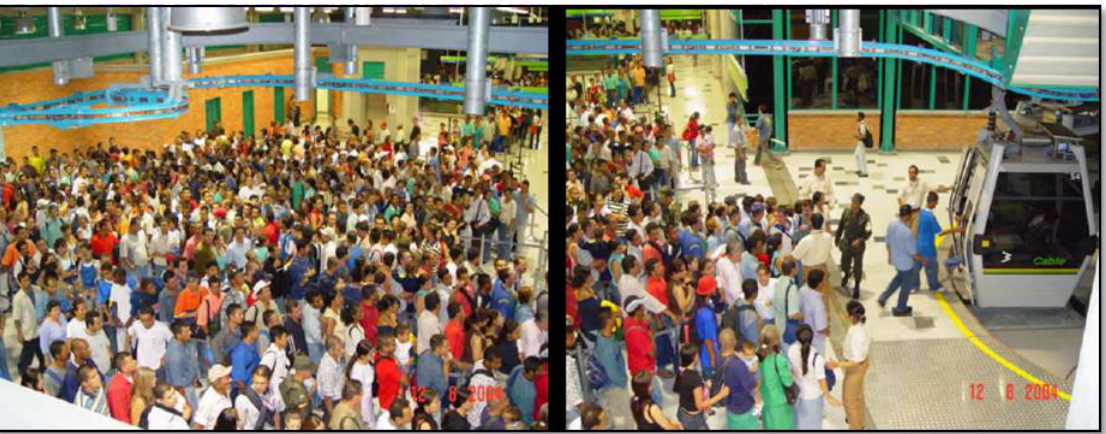
Figure 2. Peak hour queues at Metrocable stations. Source: Metro de Medellín